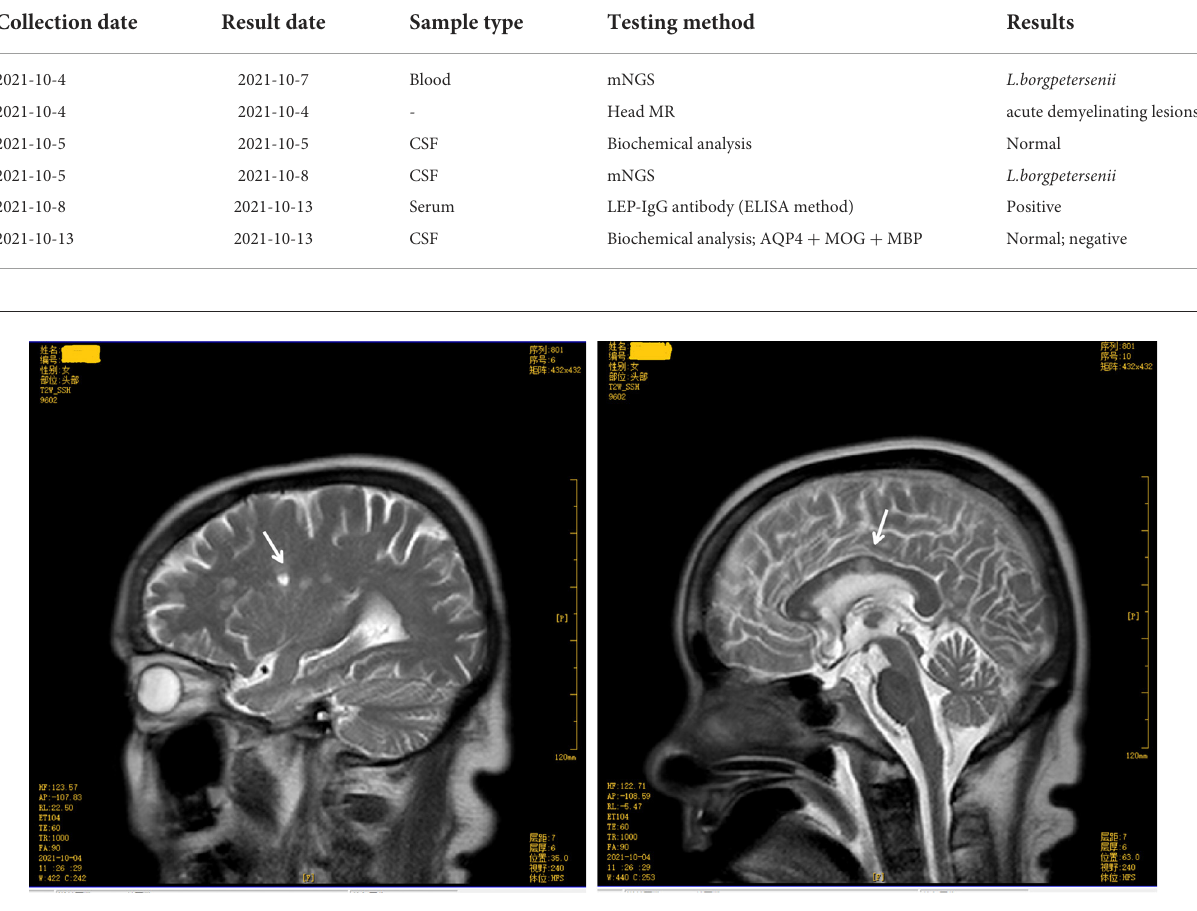
FIGURE2 Brain magnetic resonance imaging (sagittal view) T2 weighted image shows multiple abnormal oval-shaped hyperintense signal lesions in the cerebral hemisphere and